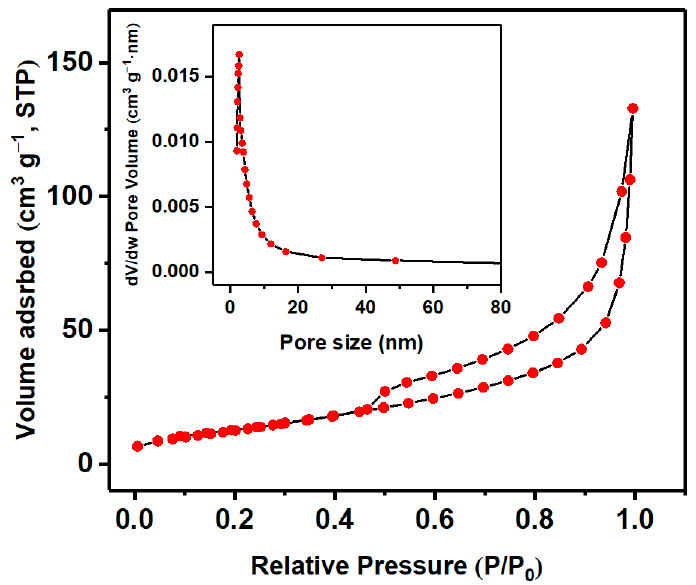
Figure 3. Nitrogen adsorption-desorption isotherm and BJH pore size distribution of Nb 2 O 5.